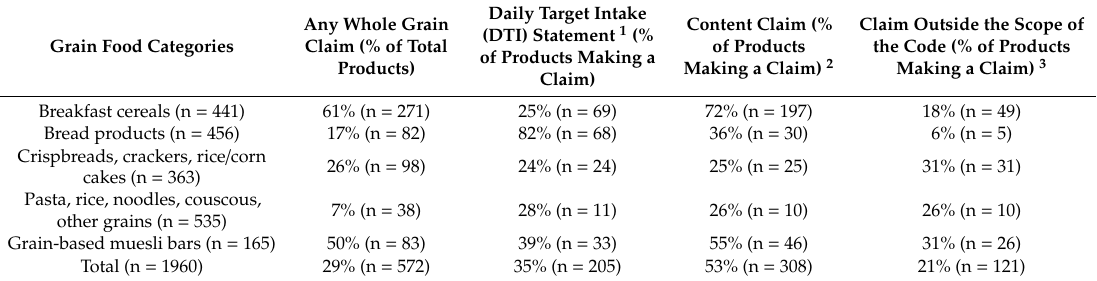
Table 2. Whole grain claims on-pack *.